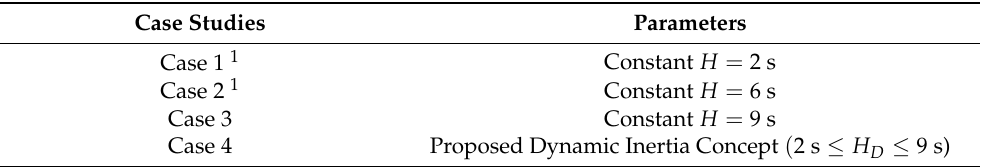
Table 5. Case Studies for SIR.